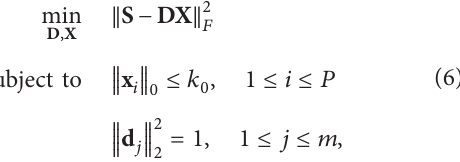
Figure 1: Illustration of how a patch s 𝑖 is extracted from a sequence of several frames of complex echo data. The small rectangles in the ultrasound image frames represent 𝑀 -axial elements in each frame which are concatenated to form the patch s 𝑖